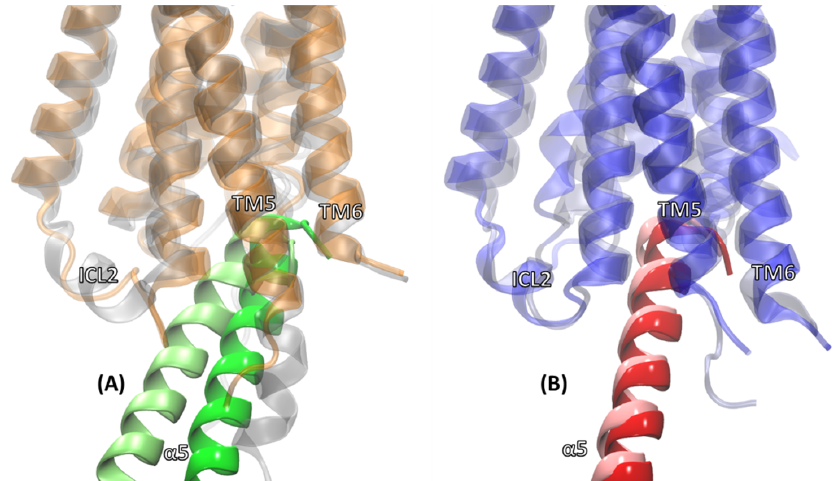
Figure 5. Overlay of the α5 helices of G proteins from the cognate complexes with the corresponding cryo-EM complexes. (A) Overlay of the Gαq α5 helix (dark green) from the average M1:Gαq MD complex and the G11 α5 helix (light green) from the M1:G11 cryo-EM complex; (B) Overlay of the Gαi α5 helix (red) from the average M2:Gαi MD complex and the Go α5 helix (pink) from the M2:Go cryo-EM complex. The rest of the Gα protein is hidden for clarity.